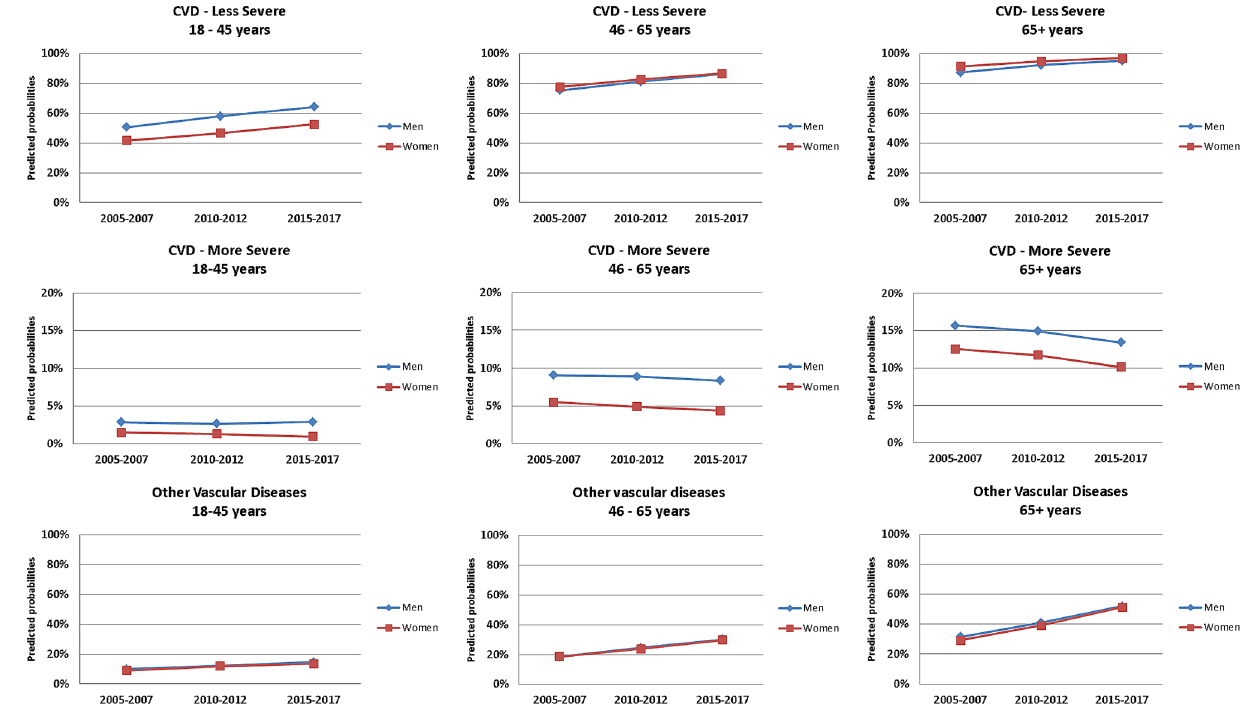
Figure 2. Predicted probabilities of having less severe CVD, more severe CVD and other vascular diseases in T2D over time period, stratified by age and